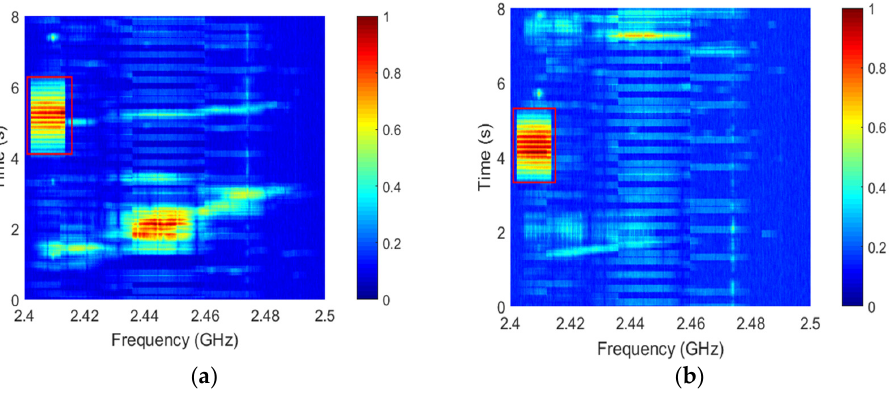
Figure 17. Normalized time–frequency diagrams after filtering at indoor distances of ( a ) 5 m and ( b ) 10 m.